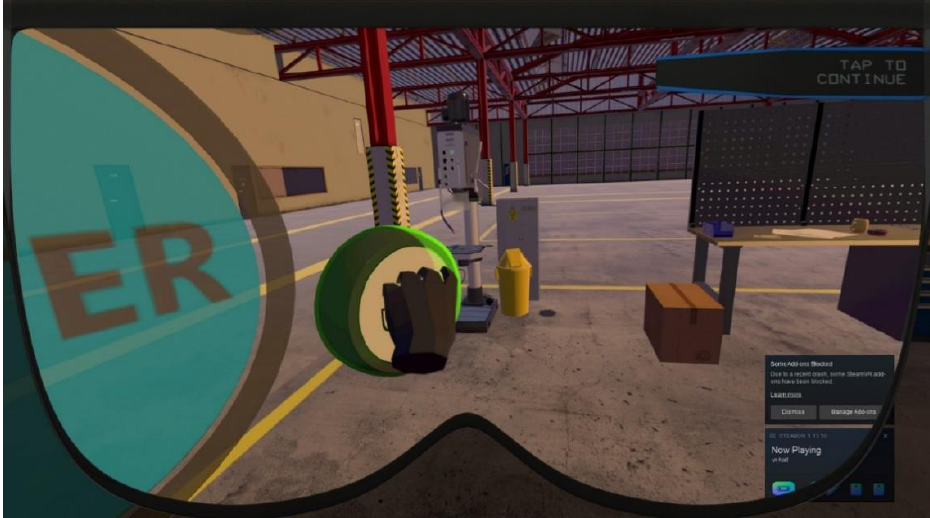
Figure 3. Level 0—an entry to the educational game.